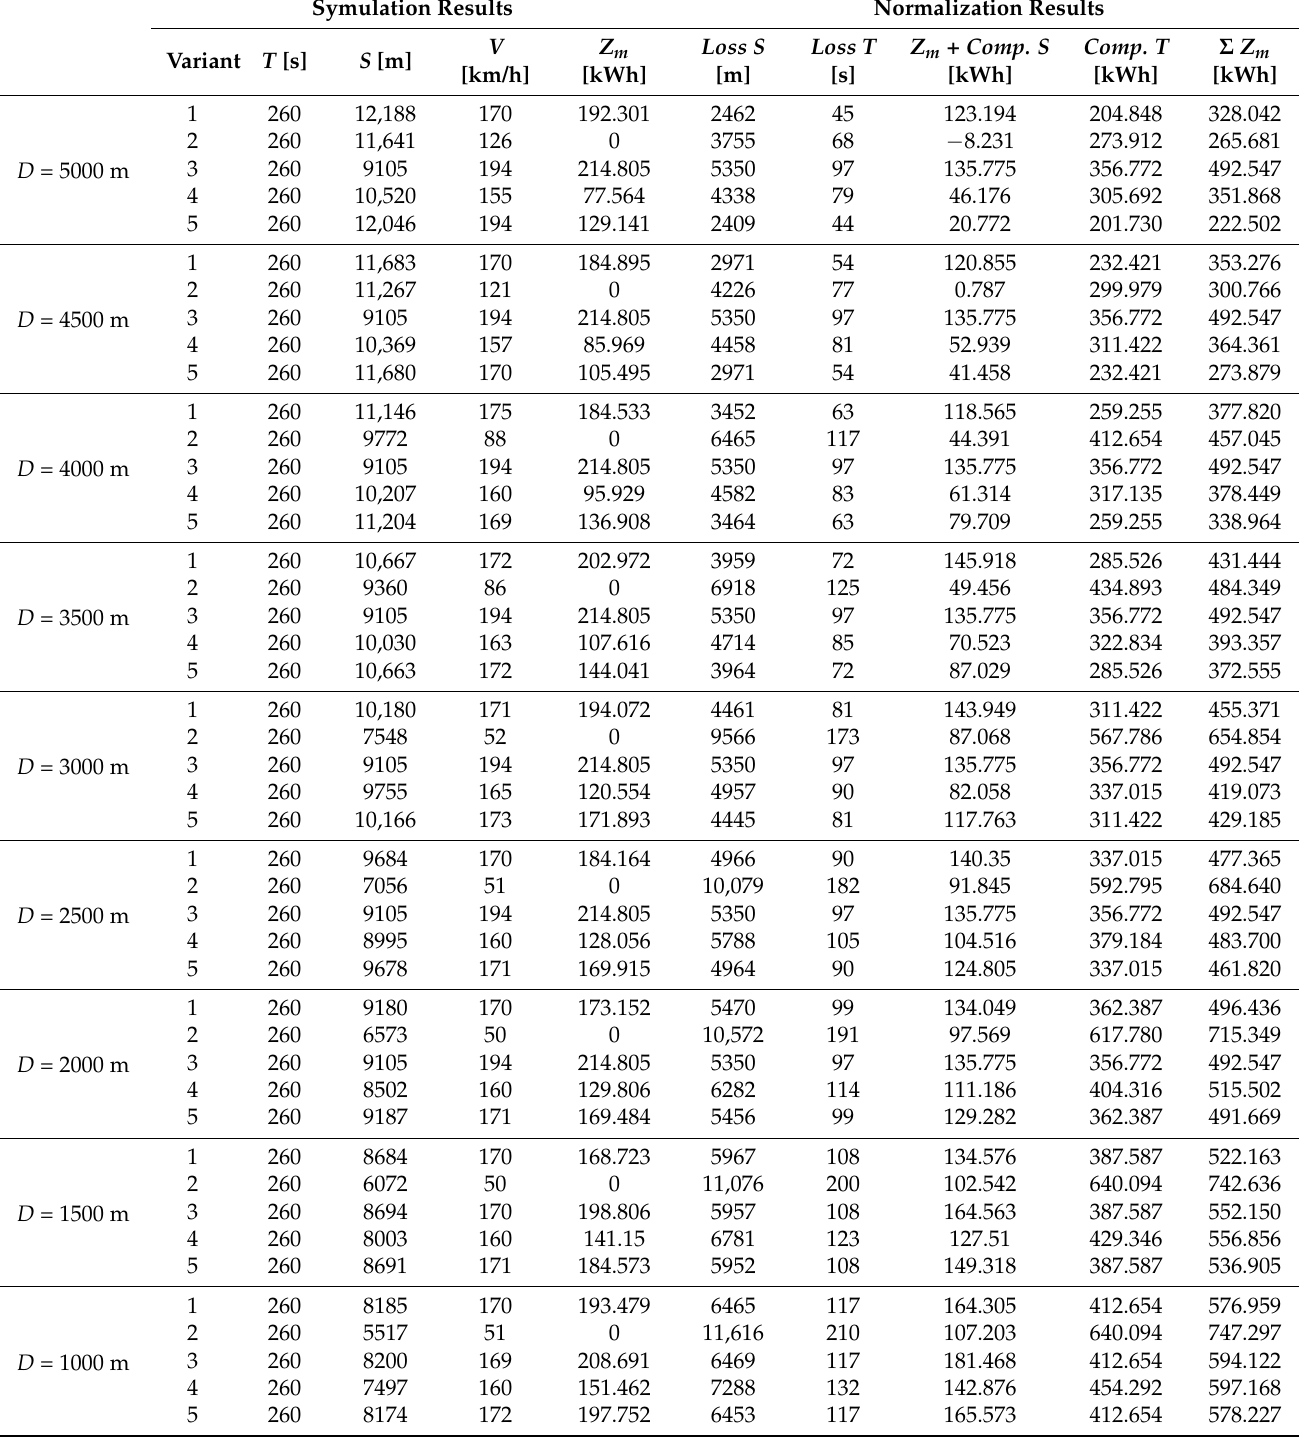
Table 4. Simulation results for context